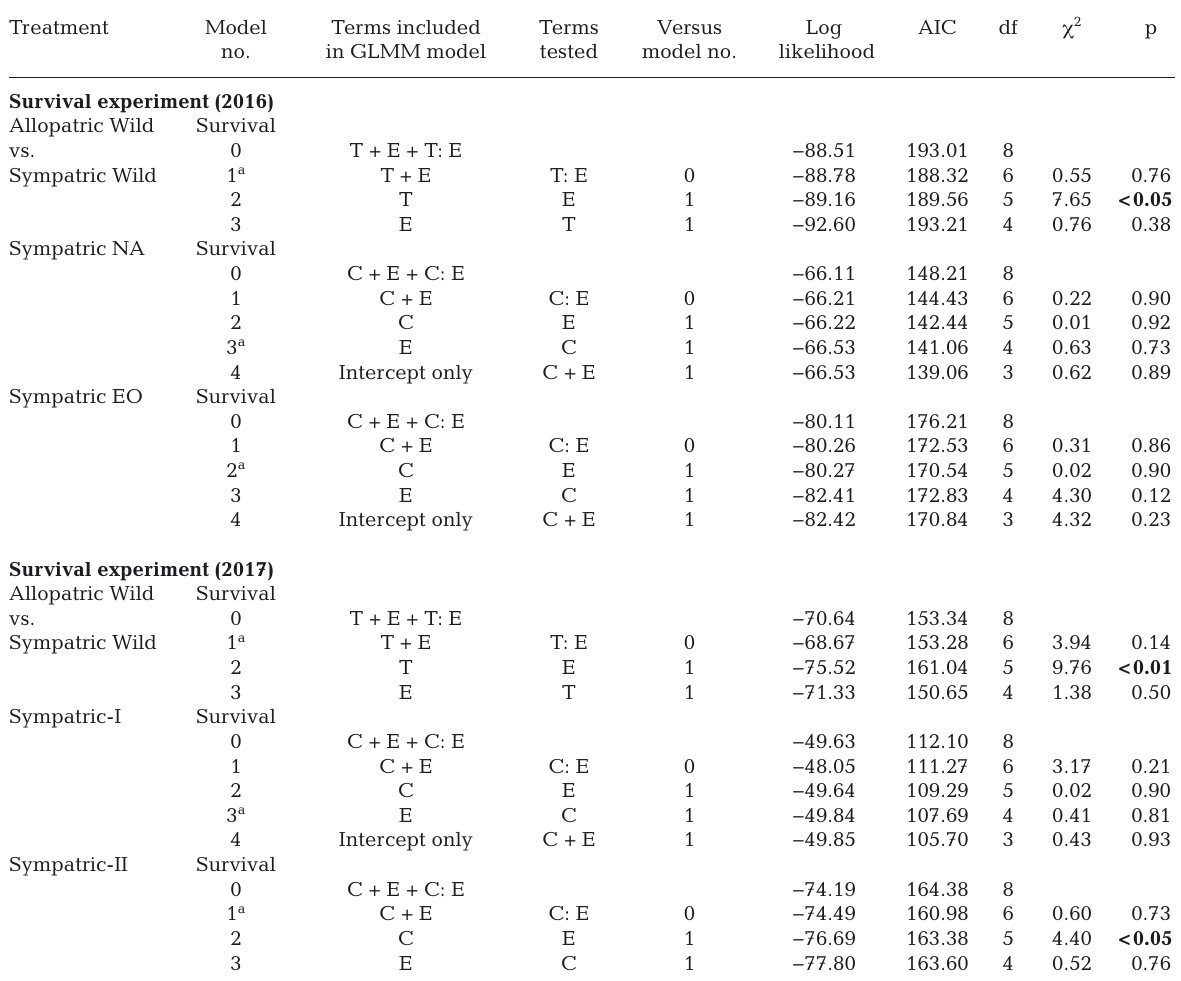
Table 4. Generalized linear mixed-effects model (GLMM) selection for investigating differences in survival of Atlantic salmon using likelihood ratio tests between treatments, environments, and cross types from the 2016 and 2017 survival